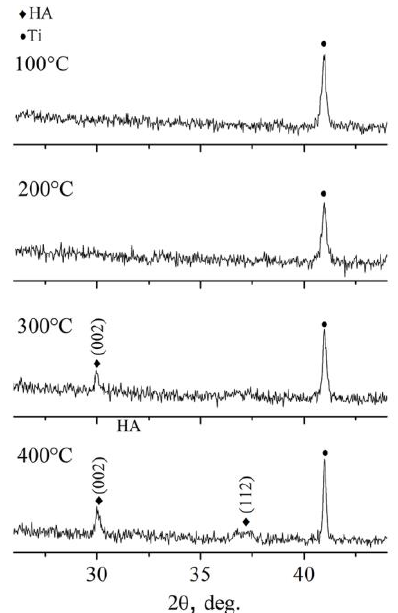
Figure 10. XRD profiles of Zn-HA coatings deposited at in situ substrate temperature 100 °C, 200 °C, 300 °C, and 400 °C. 300 ◦ C, and 400 ◦ C.